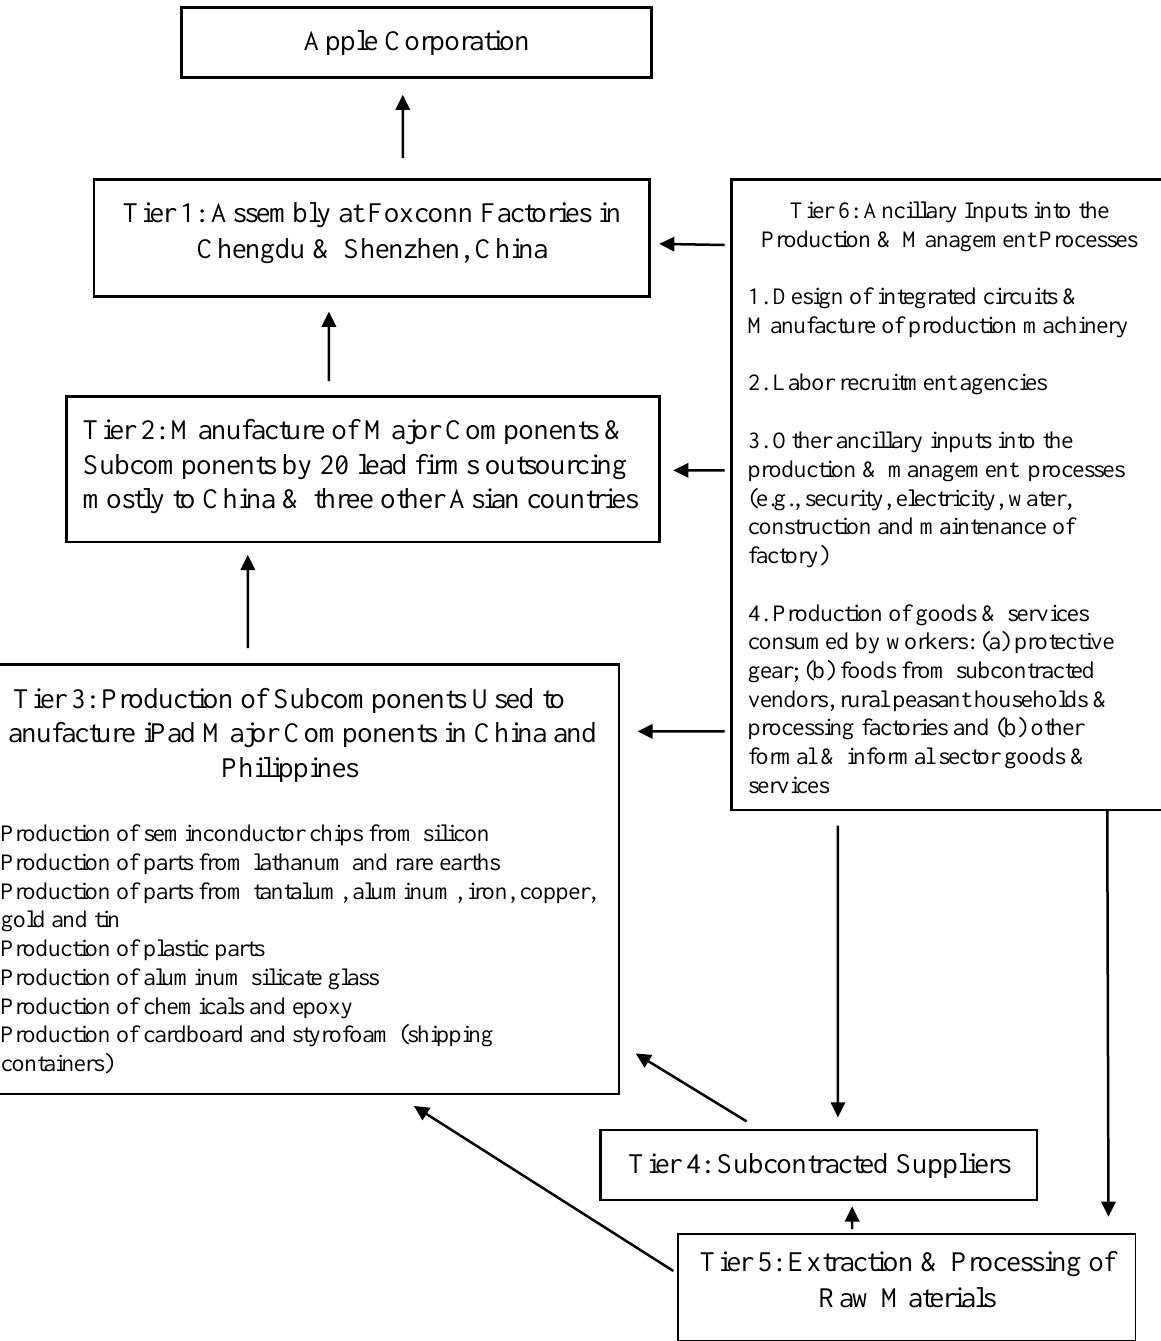
Figure 1. Supply Chain for First Generation Apple iPad, April 2010- March